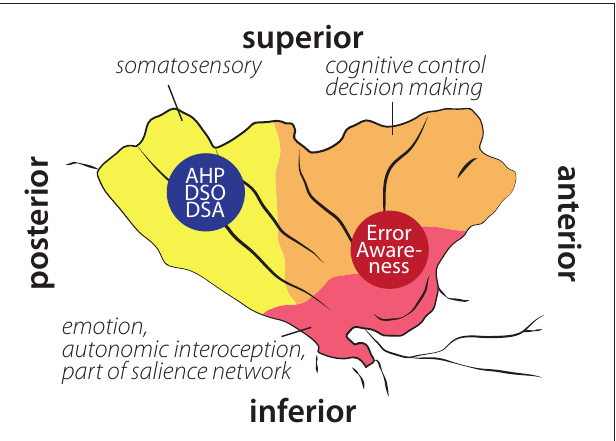
FIGURE 2 | Schematic illustration of insular cortex involvementin error awareness, anosognosia for hemiplegia (AHP), disturbed sense of ownership (DSO) and disturbed sense of agency (DSA) overlaid on schematic drawing of functional areas within the insula according to Deen et al. (2011). Localization of AHP, DSO, and DSA based on Karnath et al. (2005); Baier and Karnath (2008); Karnath and Baier (2010). Localization of error awareness based on Klein et al. (2007a); Hester et al. (2009, 2012); Orr and Hester